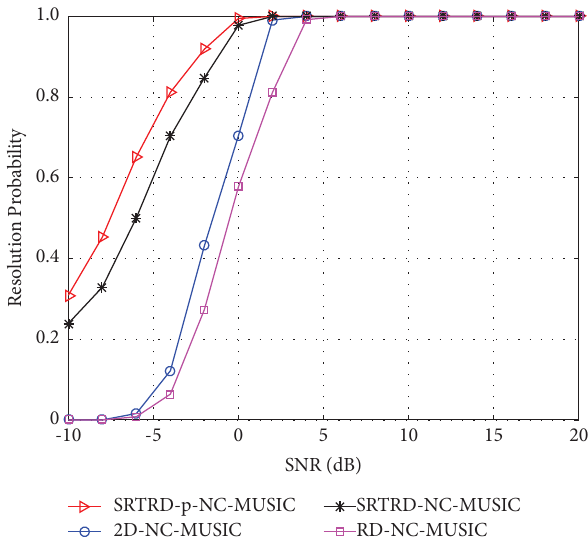
Figure 10: Spatial spectrum of the proposed SRTRD-p-NC- MUSIC and the 2D-NC-MUSIC for 10 simulations, SNR � 5dB and L �